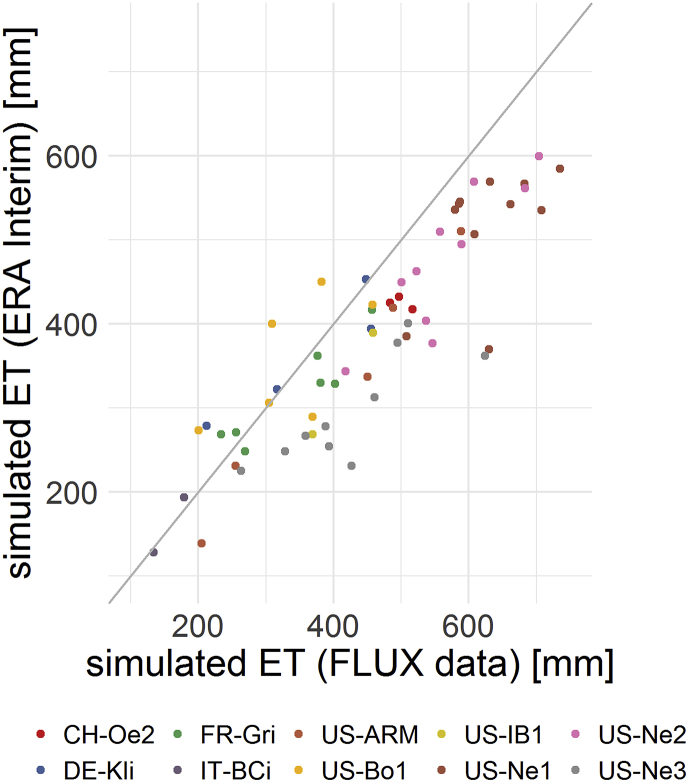
CFTW model results for ETa based on local (FLUX data) and global (ERA Interim) climate data input.